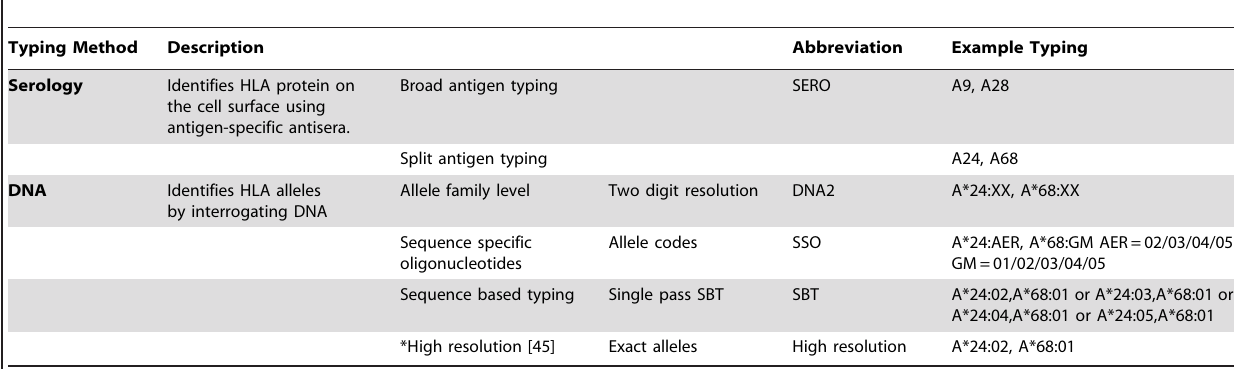
Table 1. HLA typing formats reported by NMDP contract typing